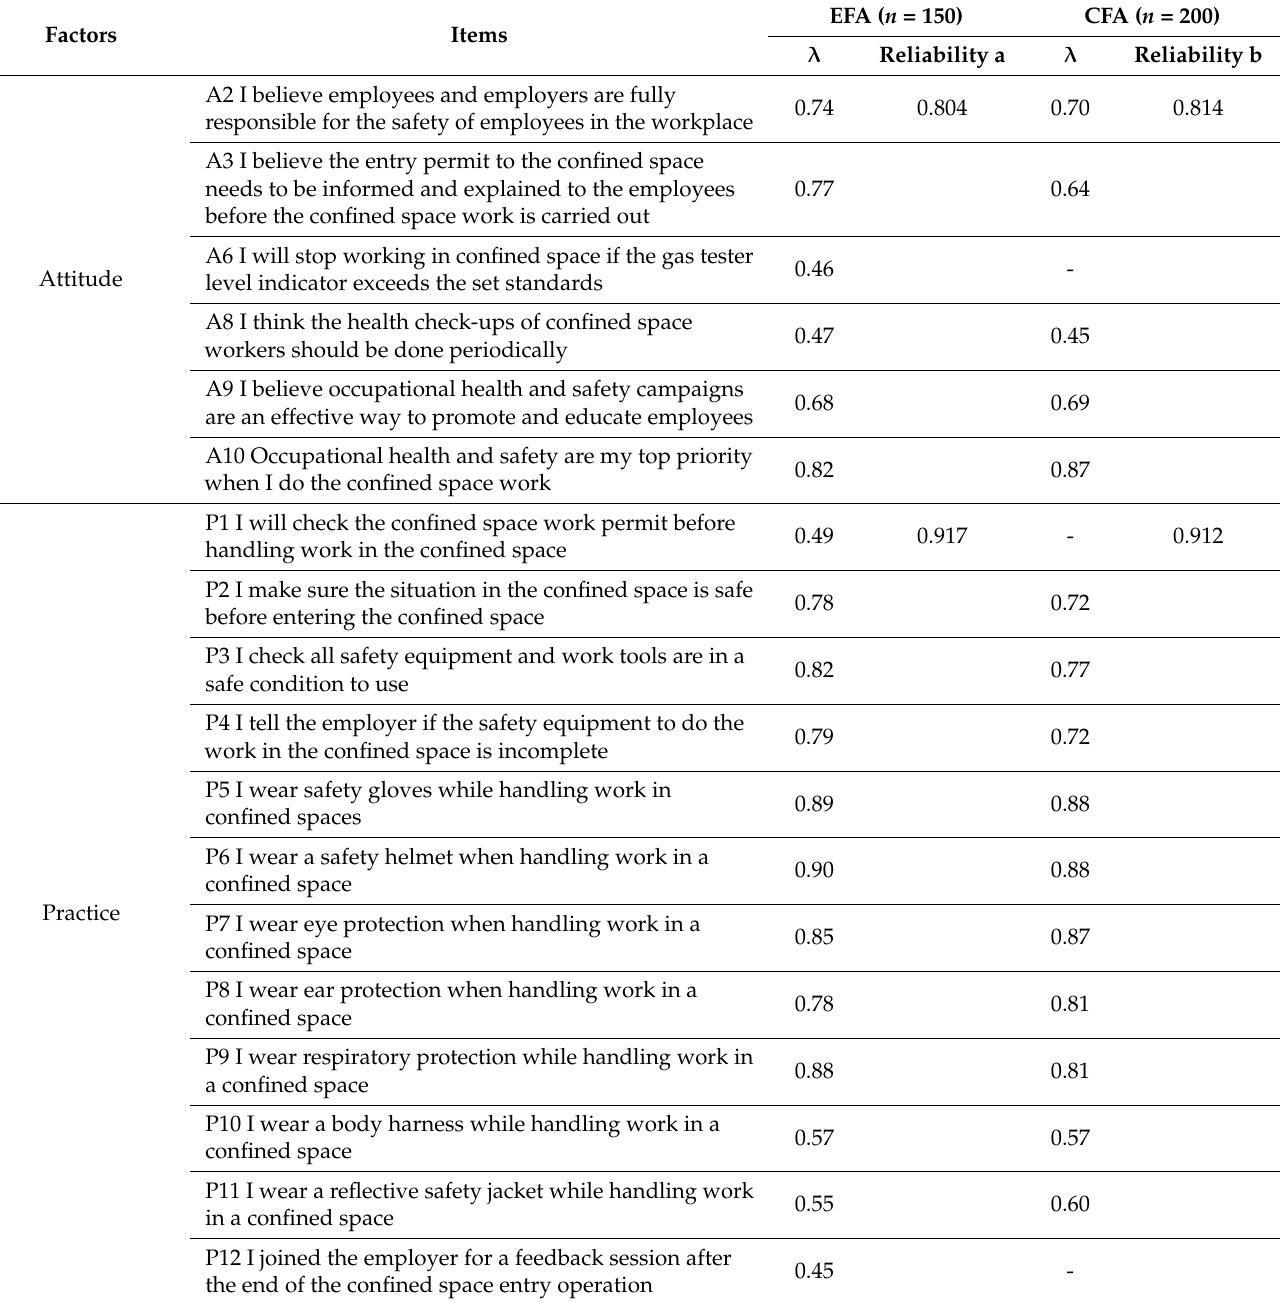
Table 4. Results of the EFA and CFA of the attitude and practice